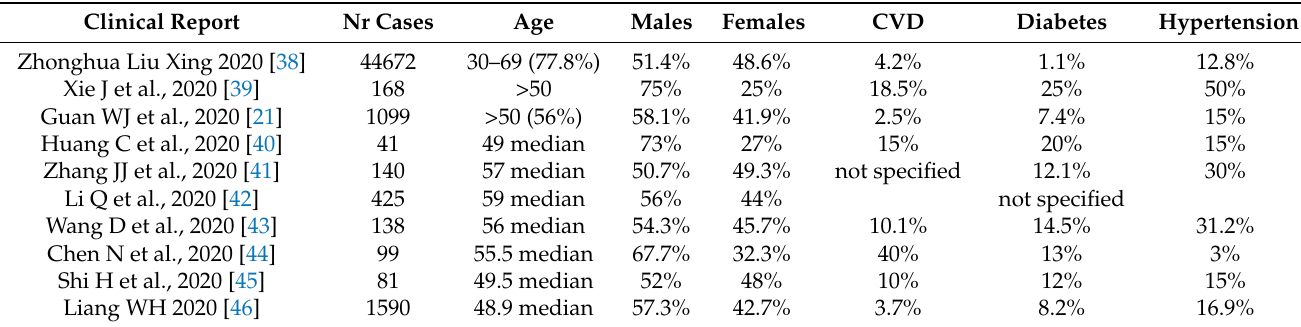
Table 2. Percentage of COVID19 patients with pre-existing conditions identified in the reported clinical studies.